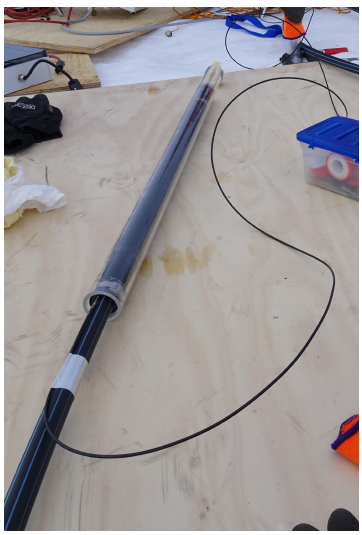
Figure 4. Packer inserted into a Plexiglas tube to test inflation. The inner diameter of the tube is identical to the borehole diameter.